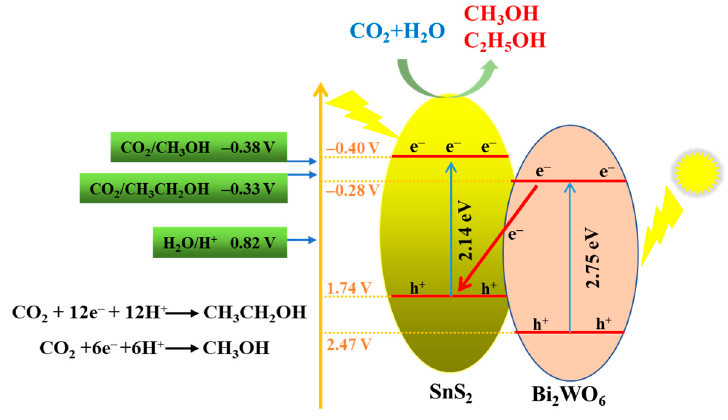
Figure 8. Mechanism diagram of photocatalytic reaction.